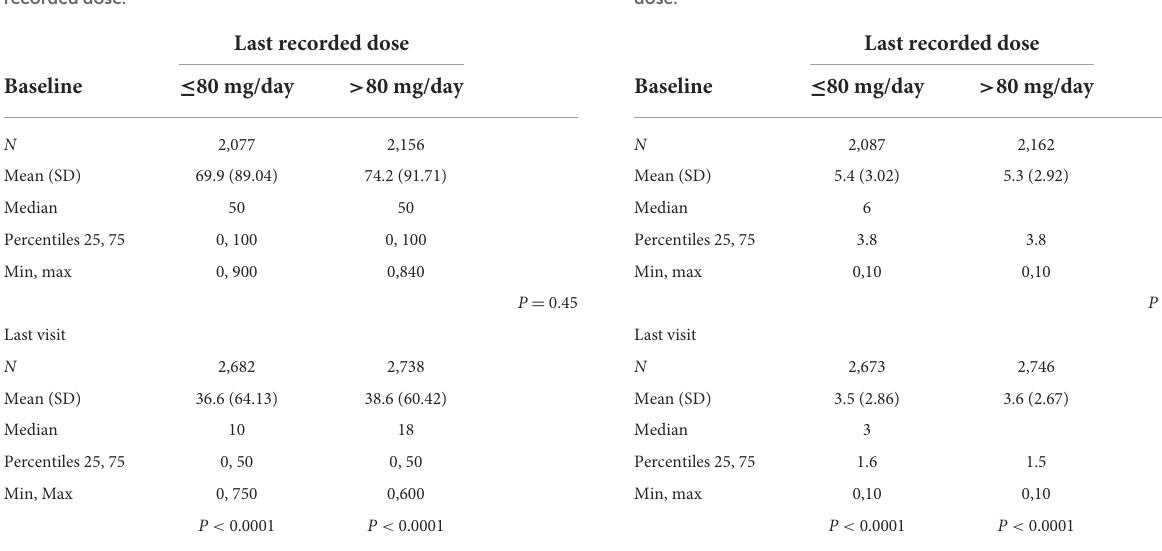
TABLE 3A Alcohol consumption for the overall population – last recorded dose.